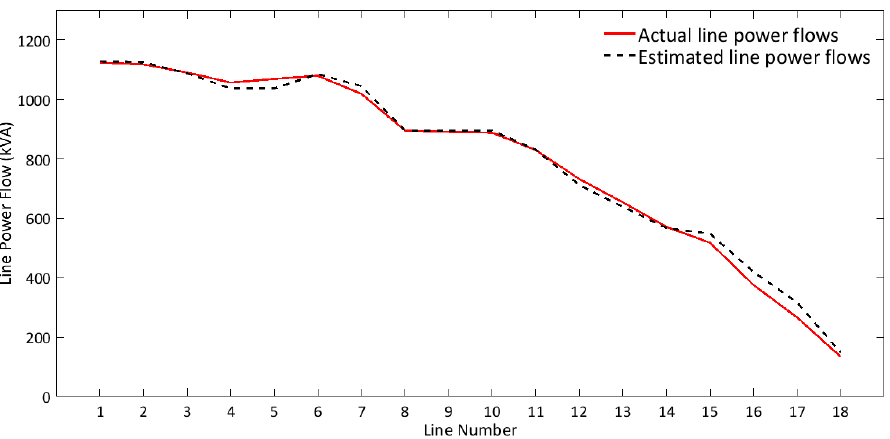
Figure 18. The estimated and actual line power flows at 12:00 p.m. (sunny